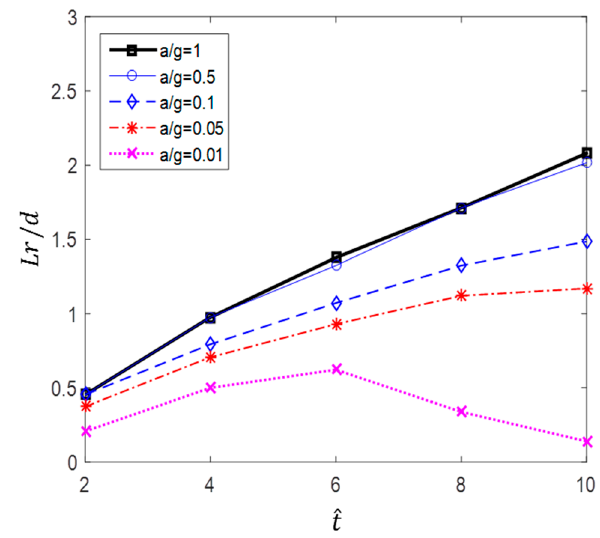
Figure 19. Recirculation length versus ˆ t for various accelerations.